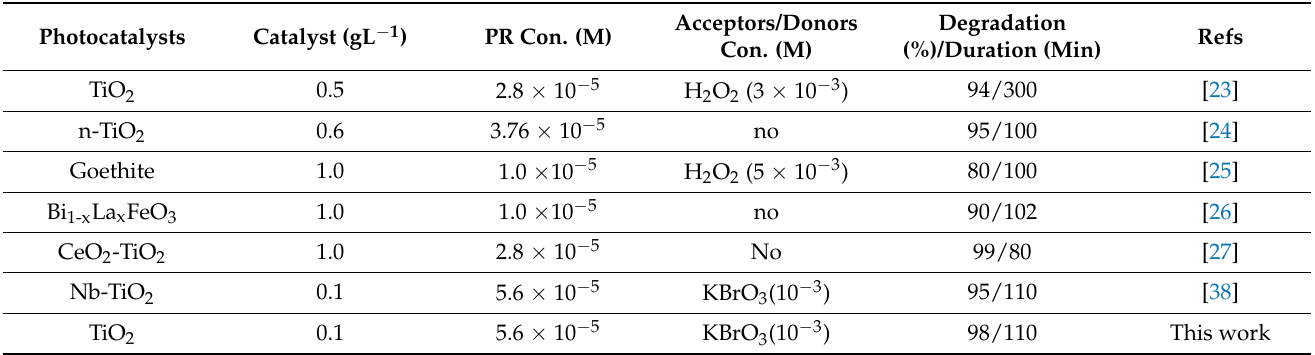
Table 2. Comparison of the current work and some previous work for PR degradation using different